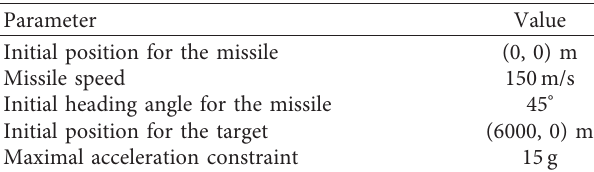
Table 1: Simulation parameters.